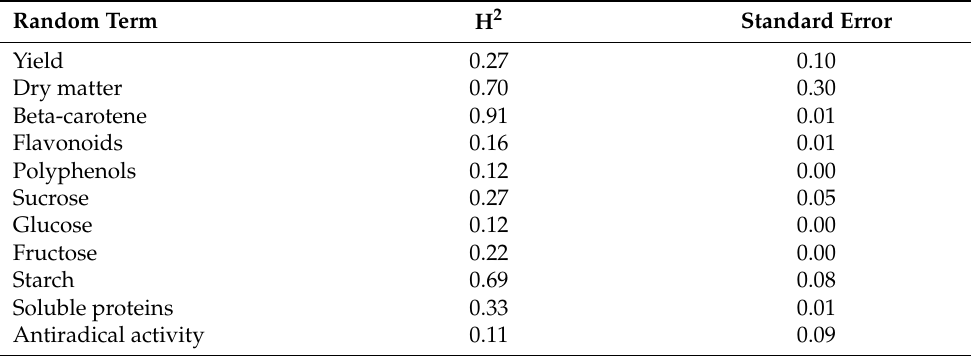
Table 5. Broad sense heritability (H 2 ) of nutraceutical traits and storage root yield. Random